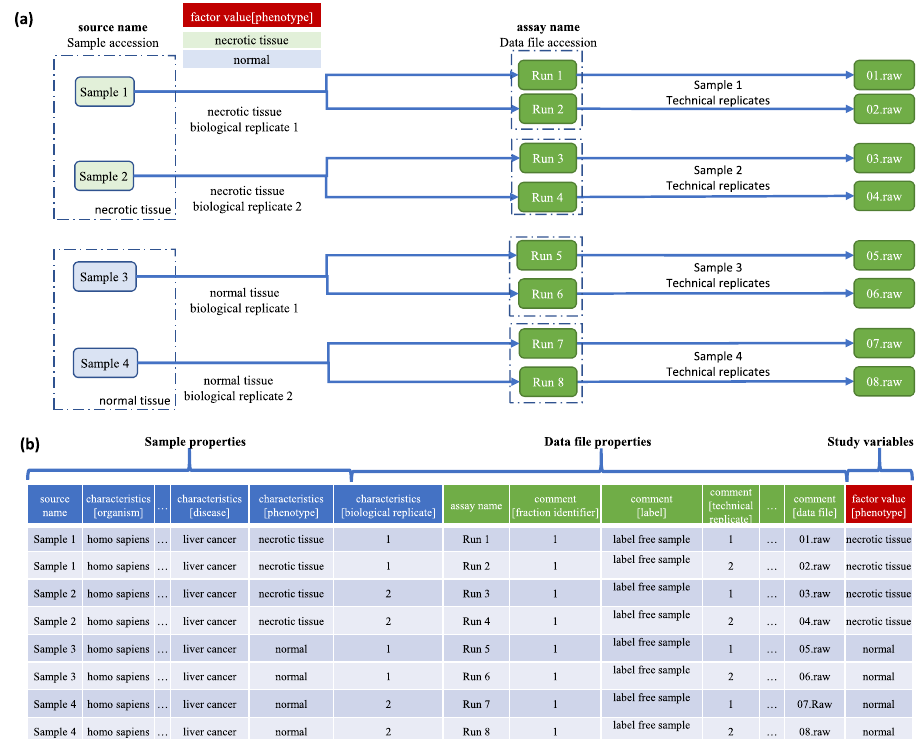
Fig. 1 SDRF-Proteomics representation for a label-free-based experiment without fractionation. a Experimental design, including two biological replicates and two technical replicates per biological replicate. The biological and technical replicates are de fi ned by the variable under study (e.g., phenotype). b The SDRF tab-delimited fi le, including the three main sections highlighted: sample metadata, data fi le properties, and the variables under study (factor